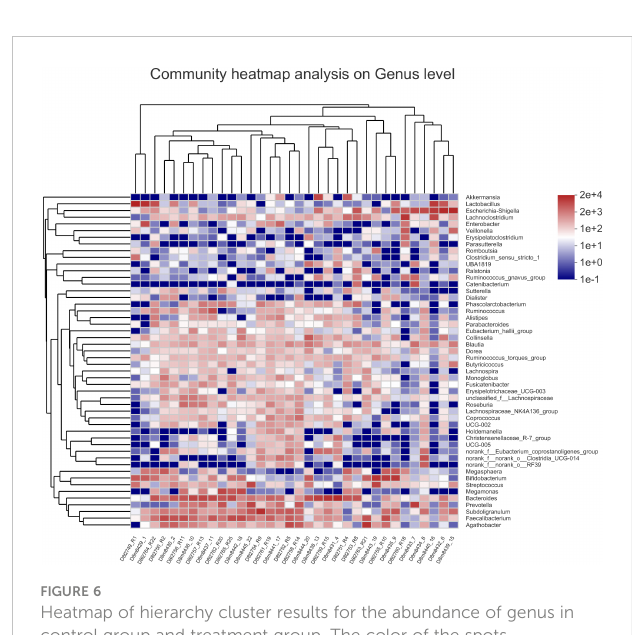
FIGURE 6 Heatmap of hierarchy cluster results for the abundance of genus in control group and treatment group. The color of the spots corresponded to the normalized and log-transformed relative abundance of the OTUs. The genus names of the OTUs are shown on the